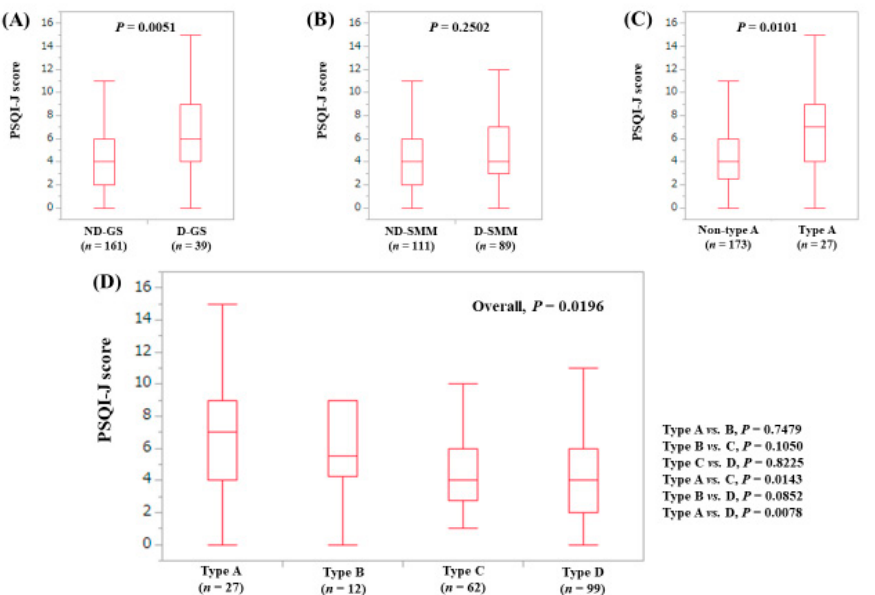
Figure 5. PSQI-J score stratified by GS and SMM for male cases ( n = 200). ( A ) Non-decreased GS vs. decreased GS. ( B ) Non-decreased SMM vs. decreased SMM. ( C ) Non-type A (type B, C and D) vs. type A. ( D ) Comparison among four types (type A, B, C and